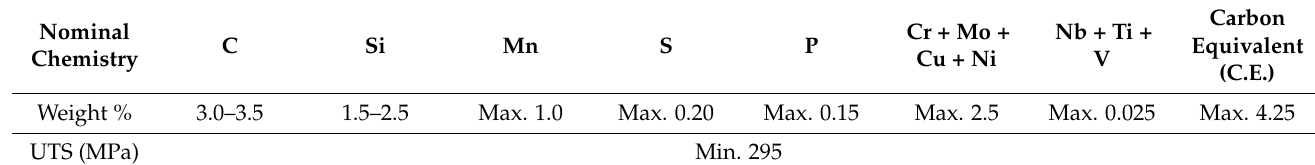
Table 1. Nominal chemistry and tensile strength of the cast iron material under investigation.